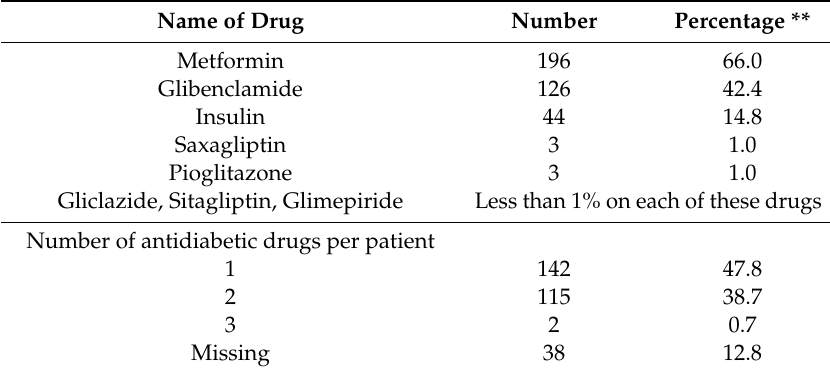
Table 4. Use of antidiabetic drugs in patients with diabetes ( N = 297 *).